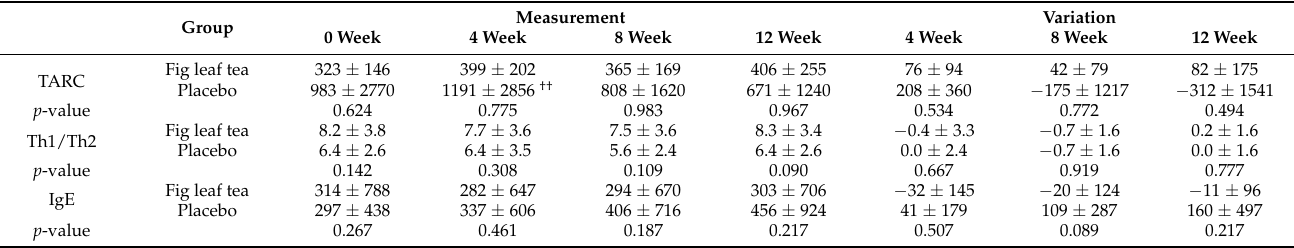
Table 6. Transition in blood components